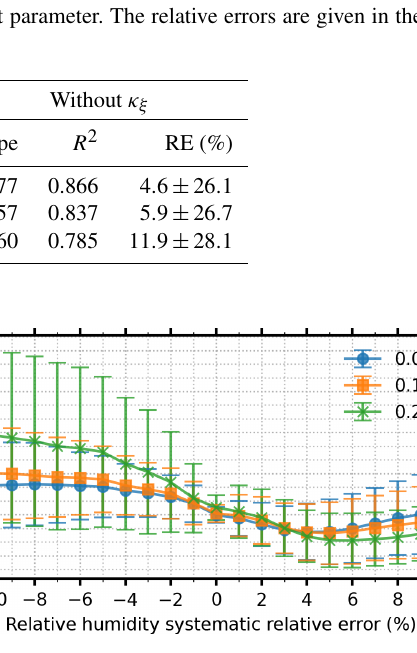
Figure 7. Relative errors in retrieved CCN number concentrations at supersaturations of 0.07%, 0.10%, and 0.20% as a function of systematic errors in relative humidity. The markers are the mean values, and the error bars denote the standard deviations.